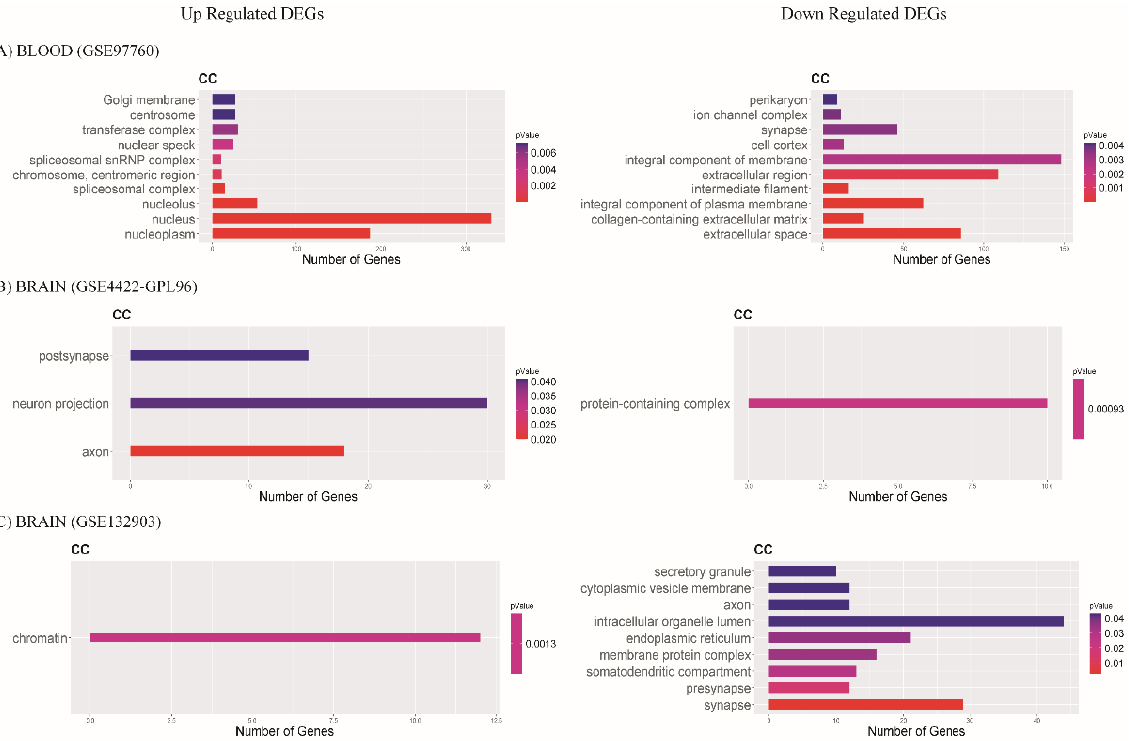
Figure 7. Bar plots show cell components (CC); most enriched GO terms with p- value < 0.05. Color scale represents p-value; X axis shows the number of genes in each GO term. Data of ( A ) blood database GSE97760, ( B ) brain database GSE84422-GPL96, and ( C ) brain database GSE132903.